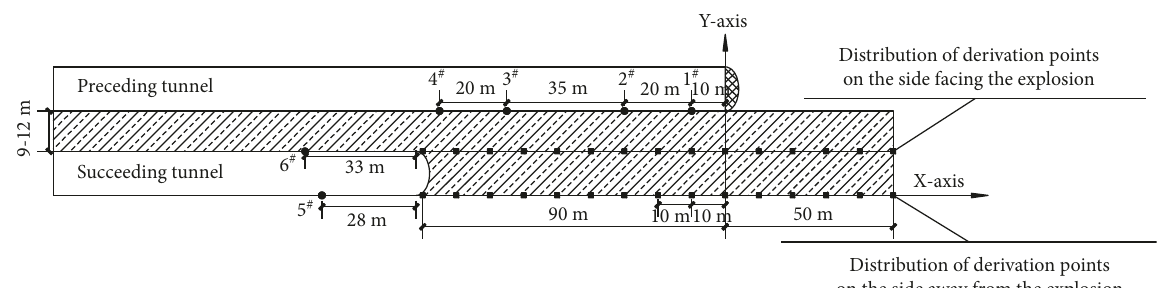
Figure 5: Schematic diagram of the layout of monitoring points and proposed points for tunnel blasting